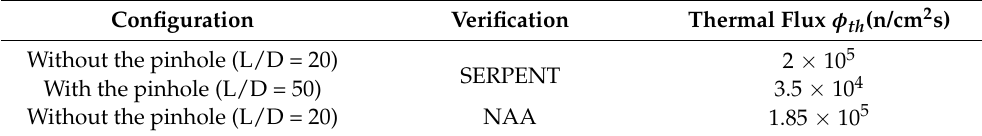
Table 3. Calculated and measured thermal neutron flux in different configurations of radial beamline.